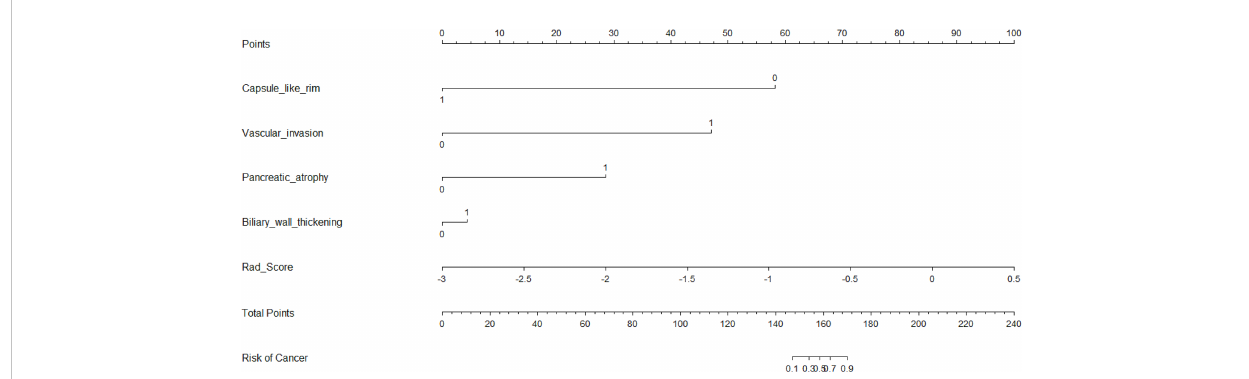
FIGURE 5 Nomogram for differentiating focal-type autoimmune pancreatitis (fAIPs) and pancreatic ductal adenocarcinoma (PDACs). The Capsule-like rim, Pancreatic atrophy, Biliary wall thickening, Vascular invasion and Rad-score were used for building the radiomics nomogram. Plotted the fi rst scale “ points ” to identify points for each predictor. When the total points were calculated by adding the scores of these fi ve predictors, the corresponding prediction probability was obtained at the last scale.